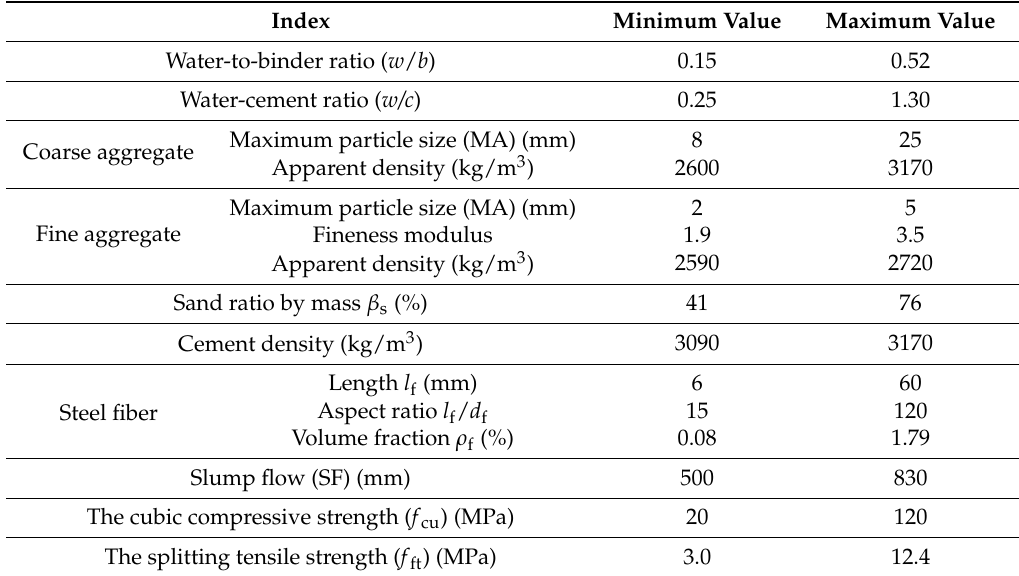
Table 1. The range of results used for the experimental